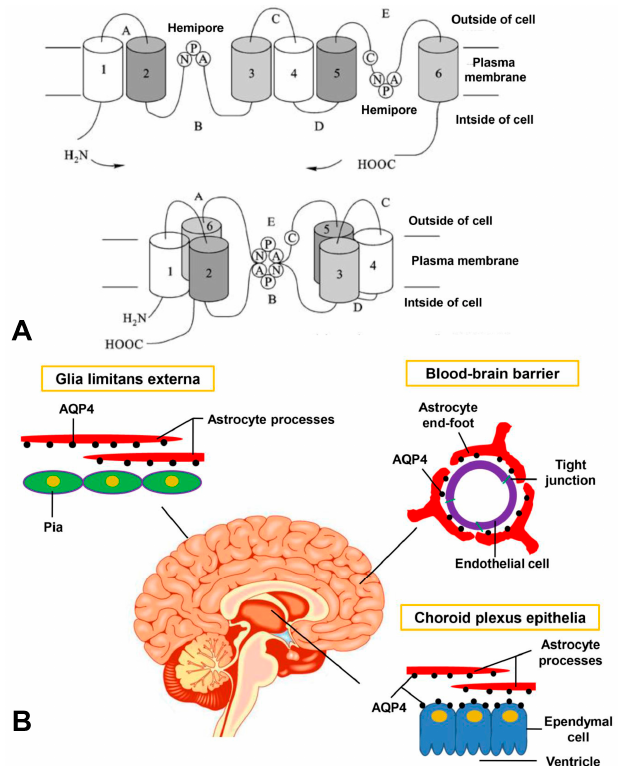
Figure 1. The structure and distribution of aquaporin-4 (AQP4). ( A ) AQP4 has six transmembrane domains (1–6) and five connecting loops (A–E). Loops B and E contain highly conserved “NPA” motifs (hemipores) that overlap midway creating a highly selective water pore; ( B ) AQP4 is polarized at the astrocyte processes facing cerebrospinal fluid (CSF)–brain and blood–brain barrier. Ependymal cells have basolateral expression of AQP4 [13,14,17].